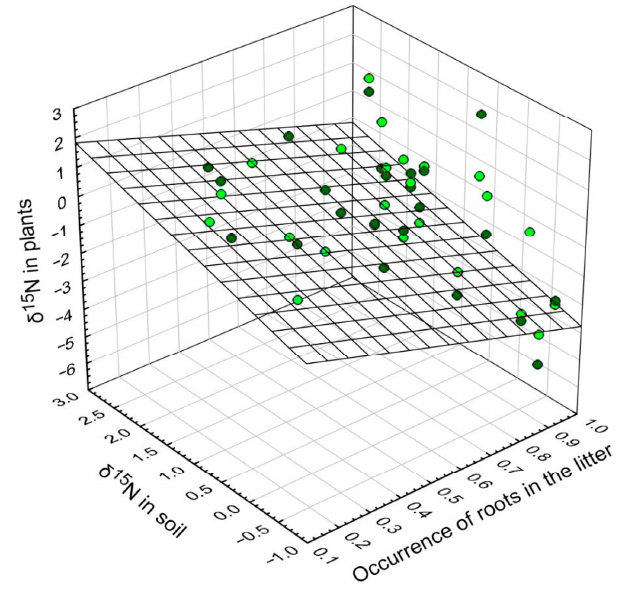
Figure 6. δ 15 N in the Betula spp. (light-green circles) and Pinus sylvestris (dark-green circles) leaves depending on δ 15 N content in the soil humus horizon and the root occurrence in the litter.